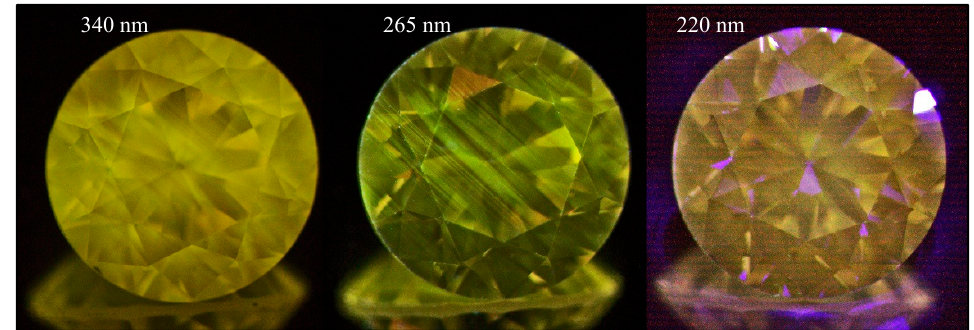
Figure 26. A light yellow-brown hydrogen-rich type IaA >> B diamond (sample TH 2.618) under three different UV excitations of the DFI system. The yellow to yellow green PL is caused mainly by the 523.7 nm defect. Photos: Dr. Thomas Hainschwang.